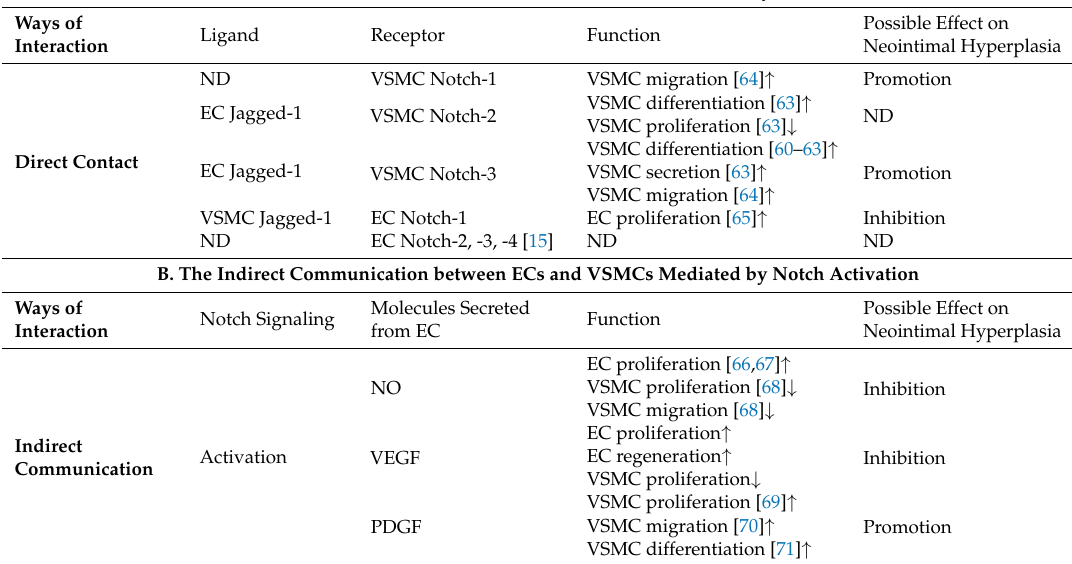
Table 1. The Notch pathway-mediated interaction between endothelial cells (ECs) and vascular smooth muscle cells